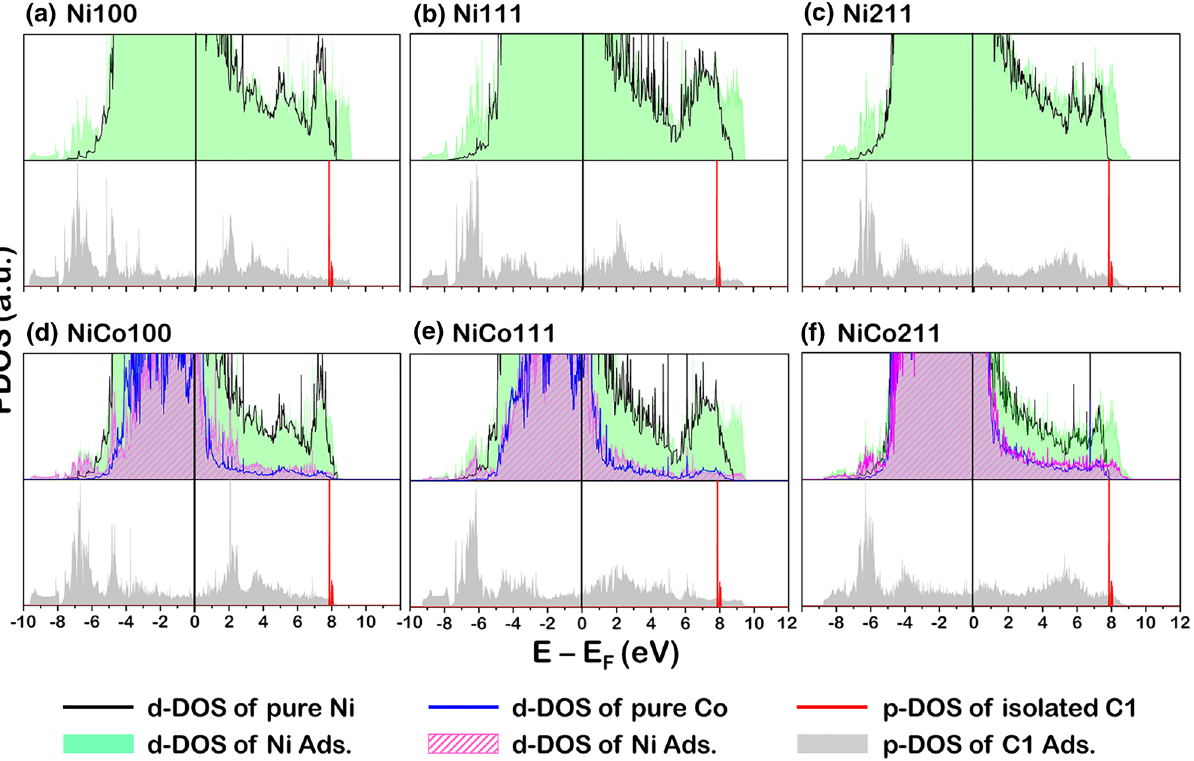
Figure 11. The PDOS profiles of fresh and 3-atom-carbon (C3)—adsorbed catalyst surface: ( a ) Ni100, ( b ) Ni111, ( c ) Ni211, ( d ) NiCo100, ( e ) NiCo111, and ( f ) NiCo211 surfaces. The top panel is the PDOS of the fresh and coked surface, while the bottom panel is the isolated and adsorbed C3 molecule. Catalysts